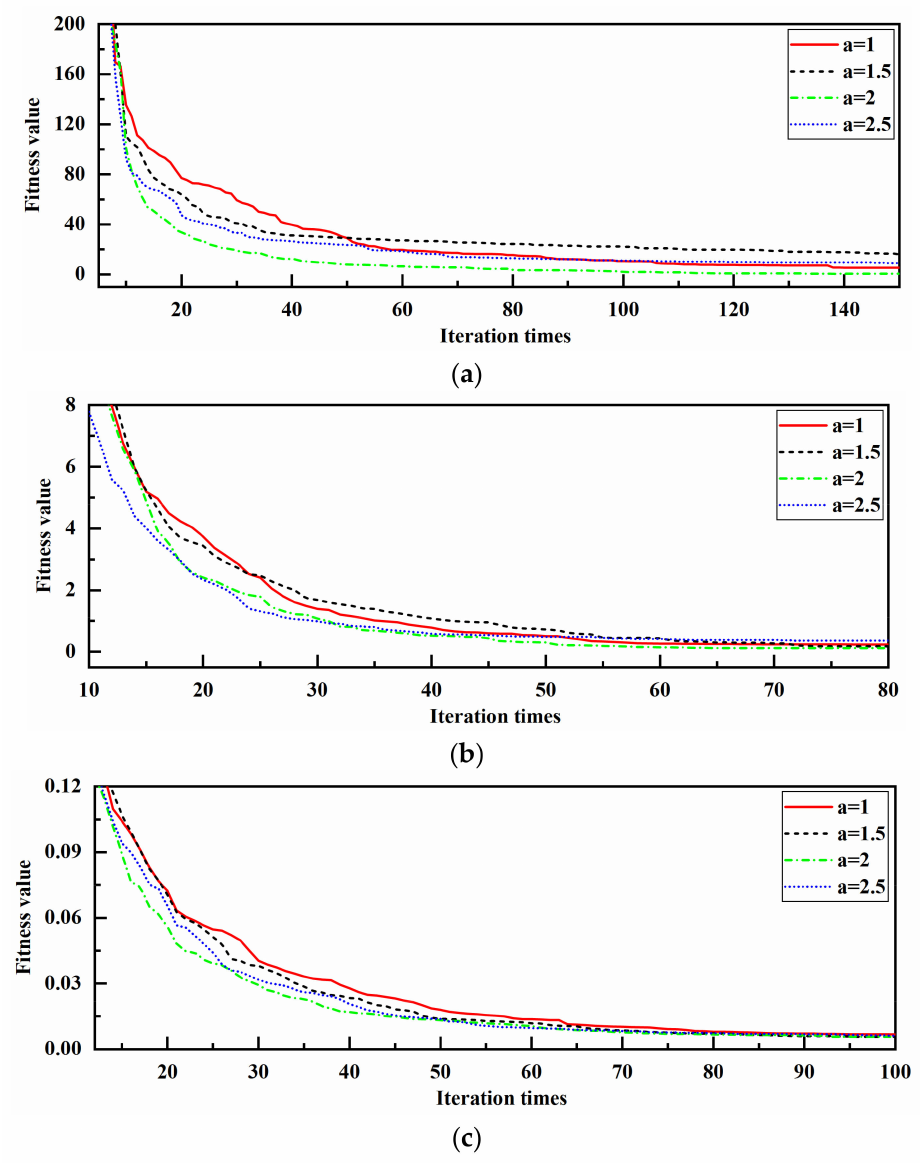
Figure 2. Influence of parameter a on SIPSO algorithm. ( a ) Curve of Rosenbrock function; ( b ) curve of Rastrigin function; ( c ) curve of Griewank